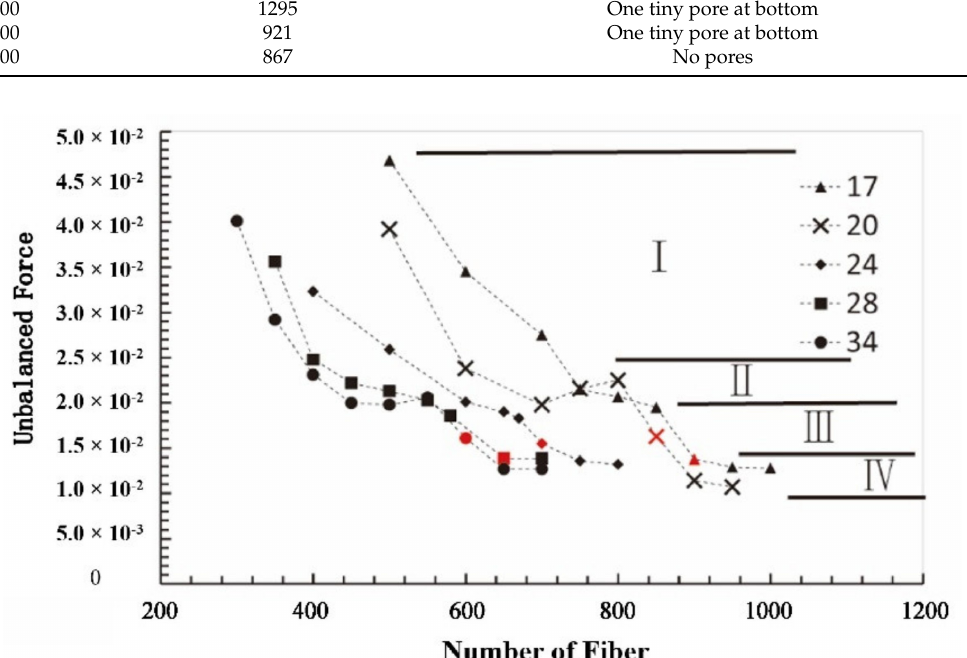
Figure 10. The variation curves of unbalanced force with fiber number increasing for different fiber aspect ratio, which can be divided into four stages: I, II (the first stable period), III, IV (the second stable period). The red symbol is the optimum fiber number determined